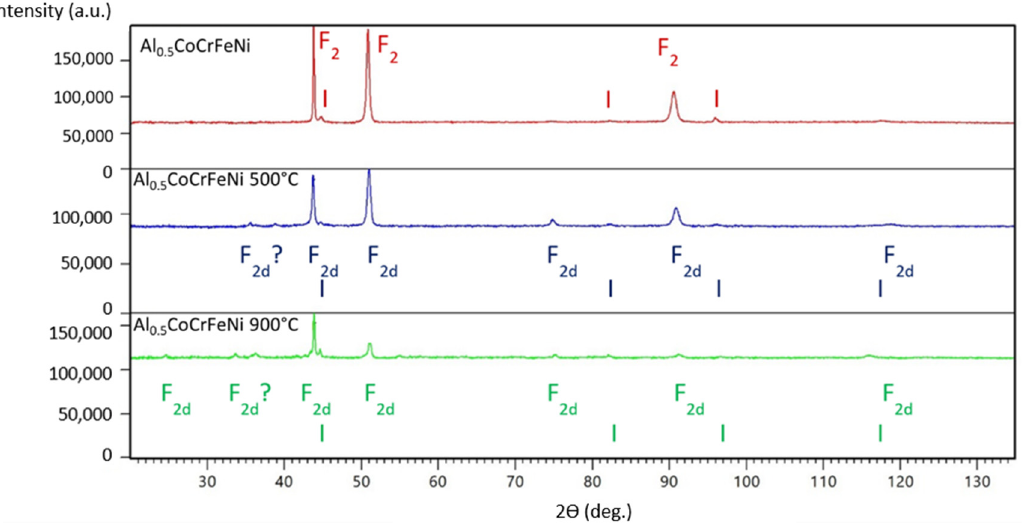
Figure 3. X-ray diagrams of as-cast Al 0.5 CoCrFeNi samples and those annealed at different temperatures. The identified phases have been marked according to the graphic symbols described in Table 2.